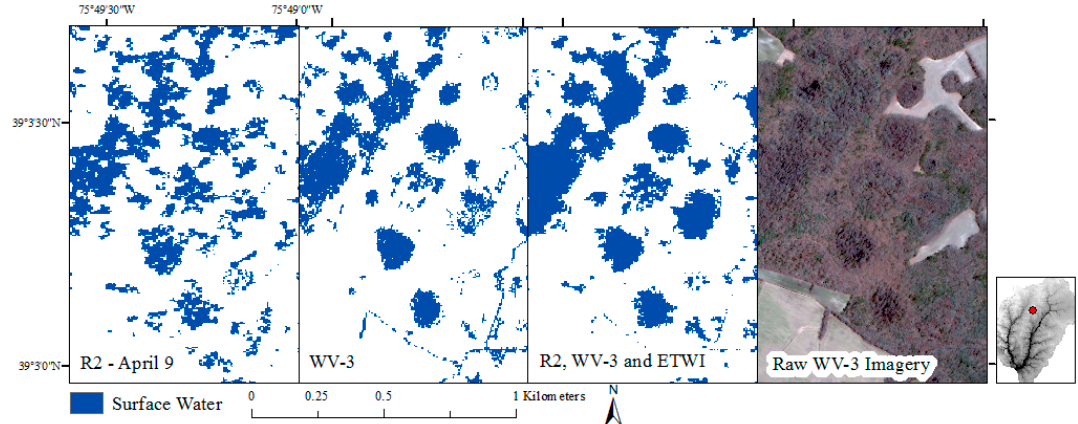
Figure 9. A second example of mapping forested surface water in which both Radarsat-2 (R2) and Worldview-3 (WV3) showed error in the outputs, but where the combined model showed a more coherent map of forested surface water extent. ETWI: enhanced topographic wetness index. Copyright 2017 Digital Globe, Next View License.